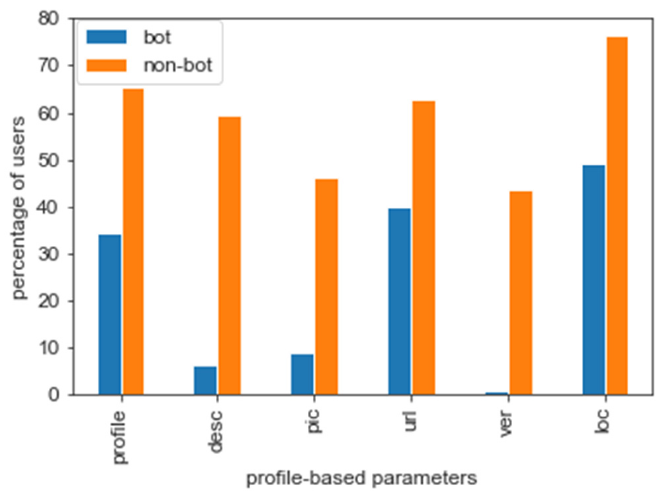
Figure 4. Study of Correlated Parameters.